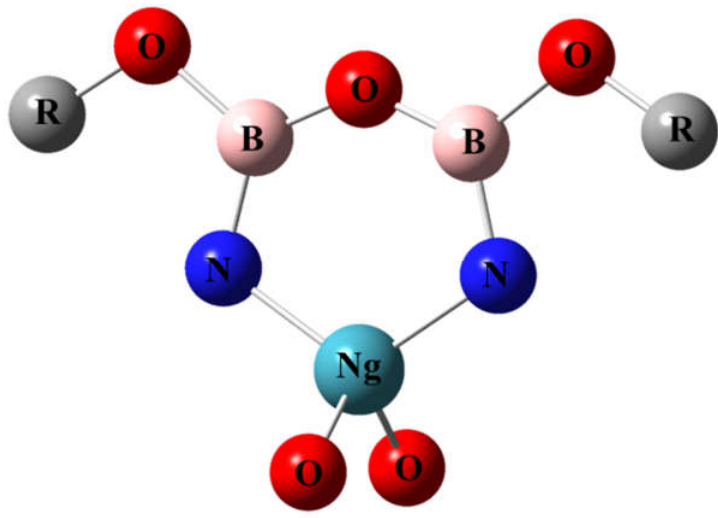
Figure 8. Possible derivatives of NgO 3 N 2 B 2 F 2 .